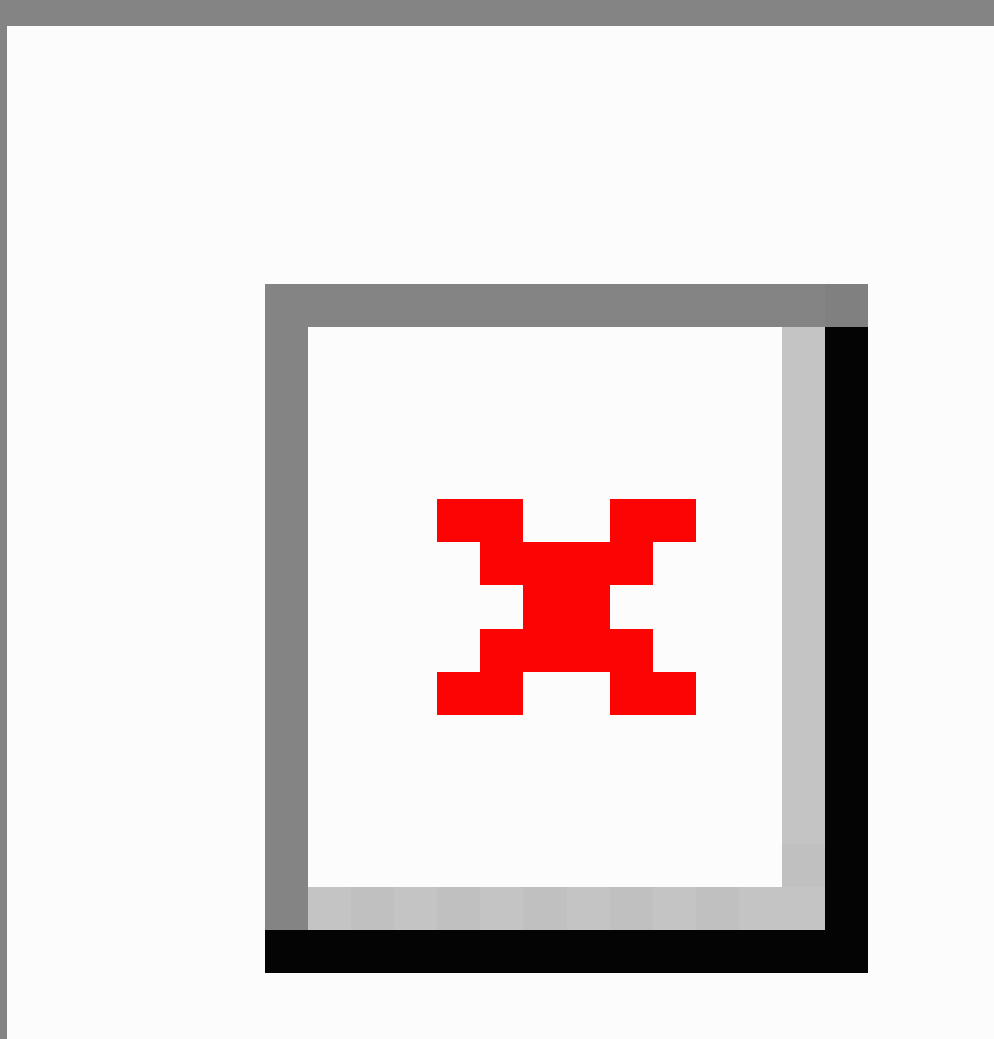
Figure 1. Review flow